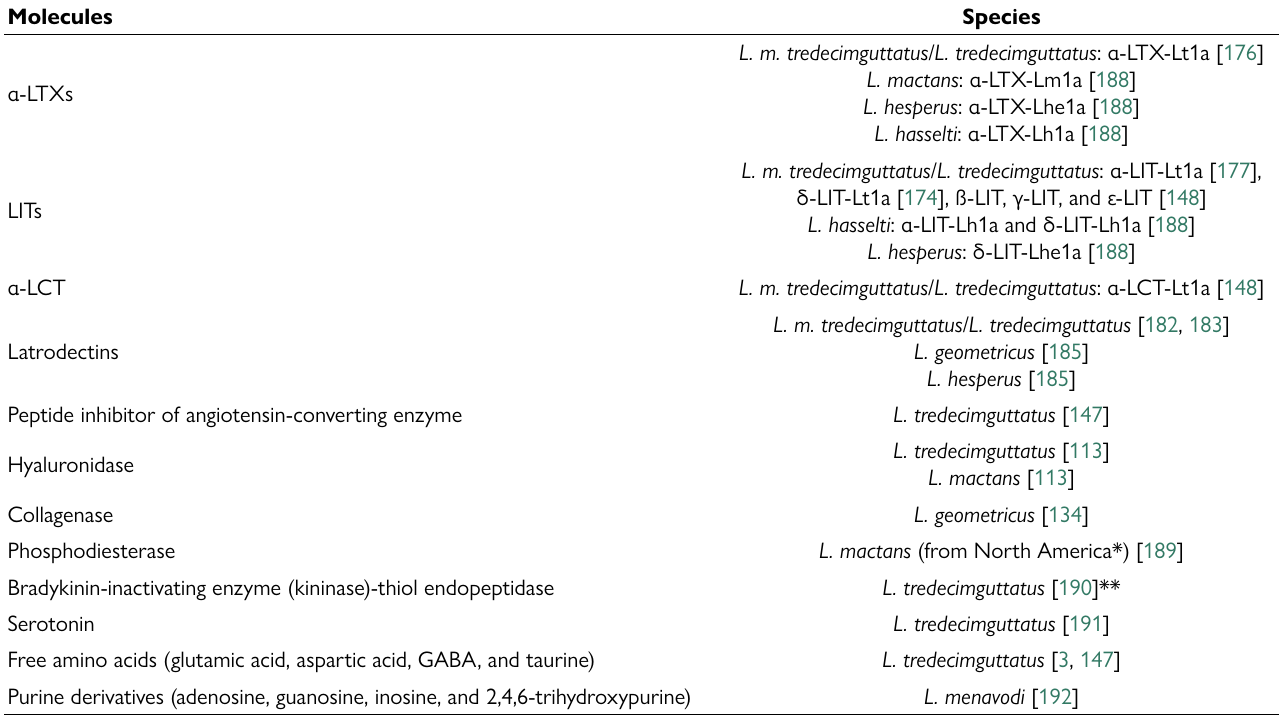
Table 2. List of isolated or biochemically tested components (enzymes or inhibitors) from the venoms of Latrodectus spp.